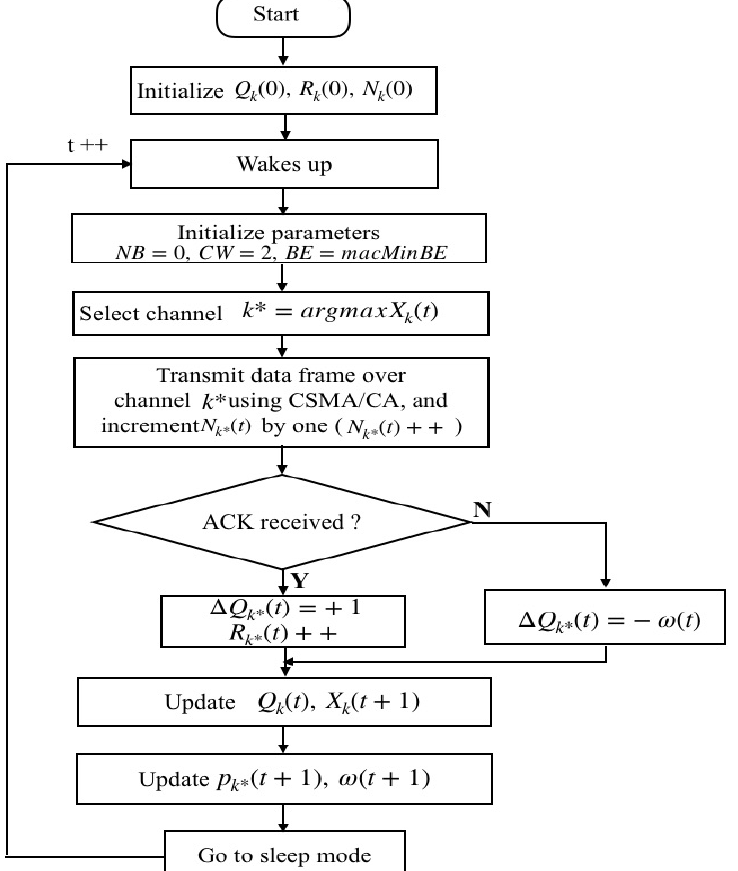
Figure 4. Flowchart of the proposed scheme.